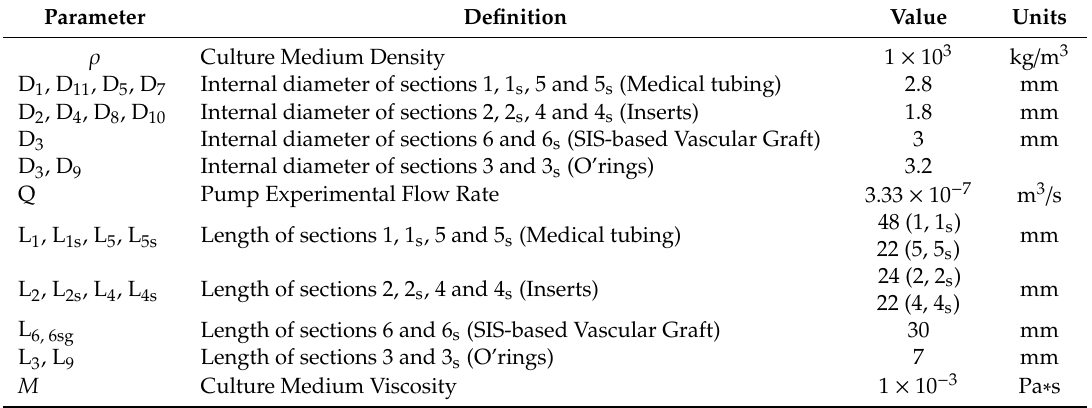
Table 1. Parameters for calculations according to the macroscopic and computational approaches. Subscript s refers to the symmetrical section of the geometry.